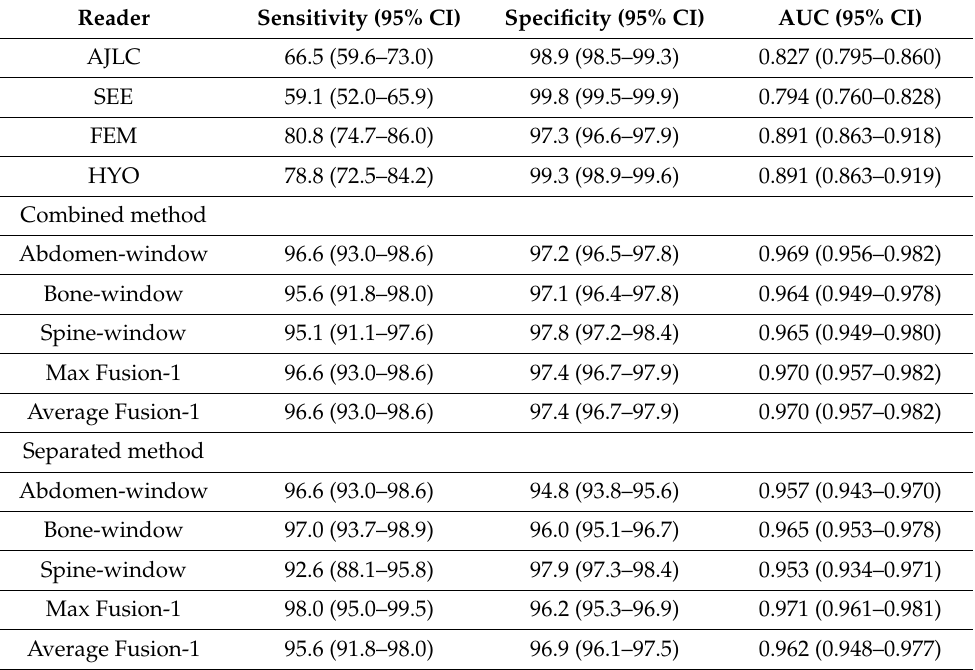
Table 4. Internal test set sensitivity, specificity, and AUCs for the DL model and radiologists using dichotomous Bilsky grading (normal/low versus high) on